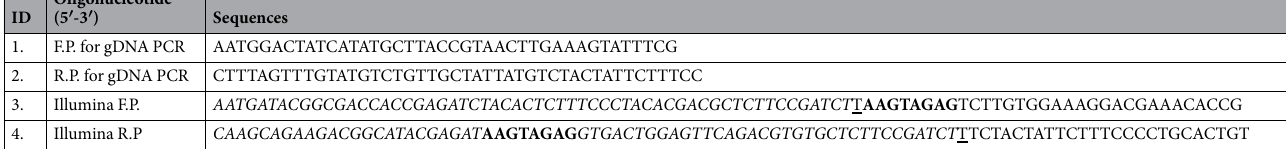
Table 2. Oligonucleotides for CRISPR library preparation (Integrated DNA Tech.). F.P.: Forward primer,